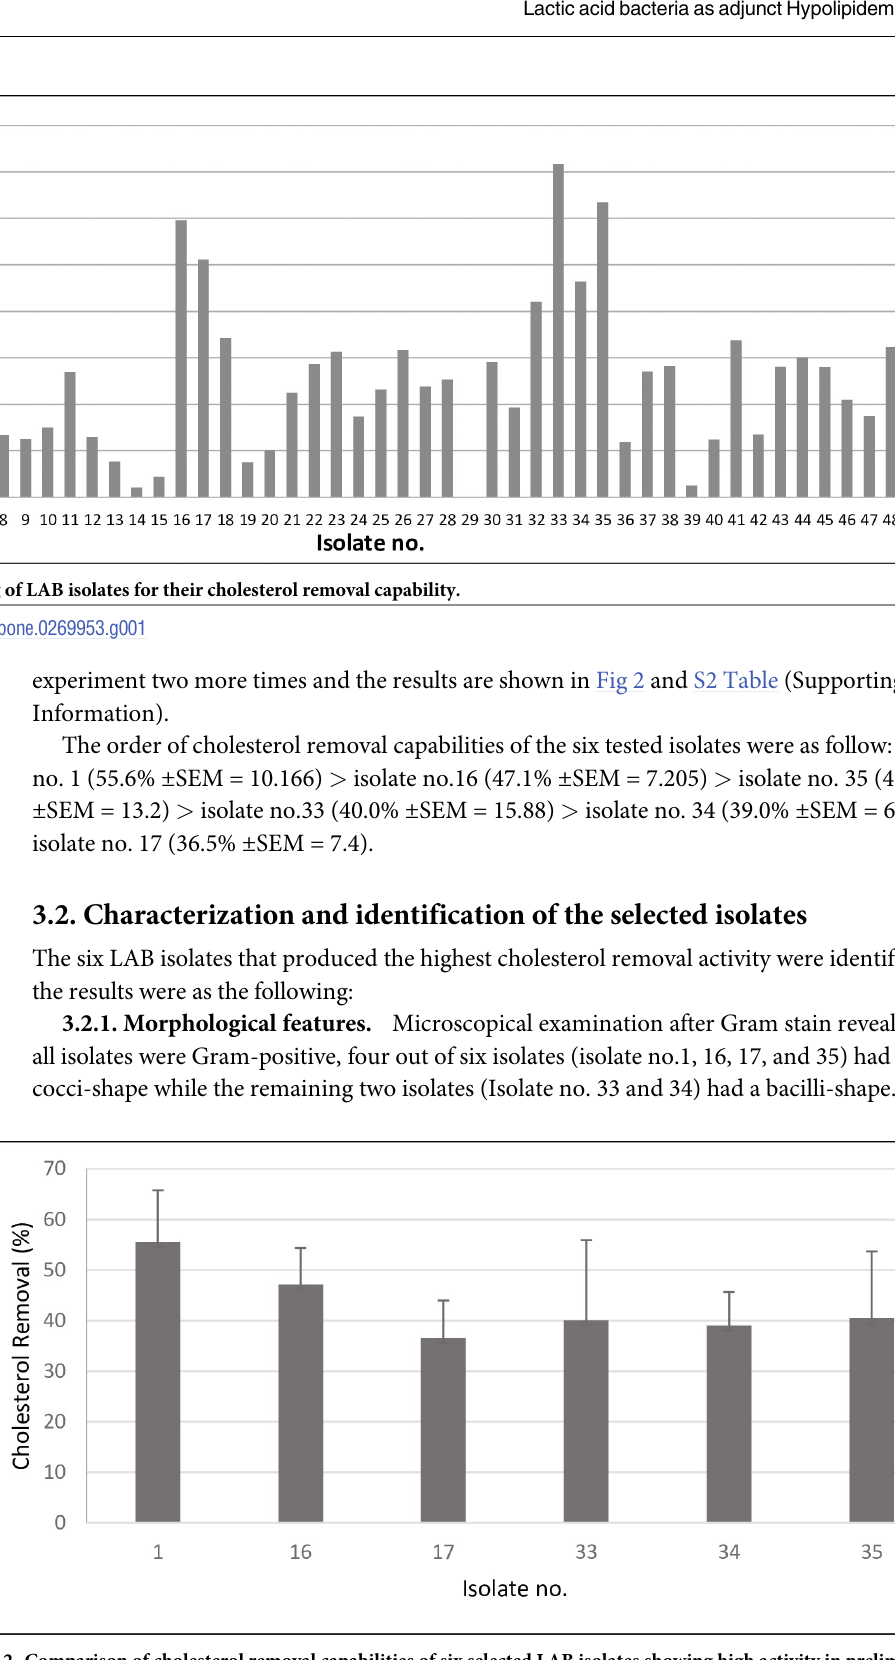
Fig 2. Comparison of cholesterol removal capabilities of six selected LAB isolates showing high activity in preliminary screening. Data are represented as the mean ± SEM (n =